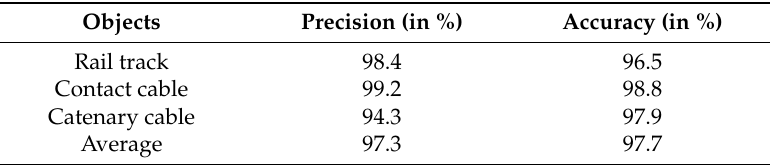
Table 3. The Achieved Classification Results at the Point Cloud